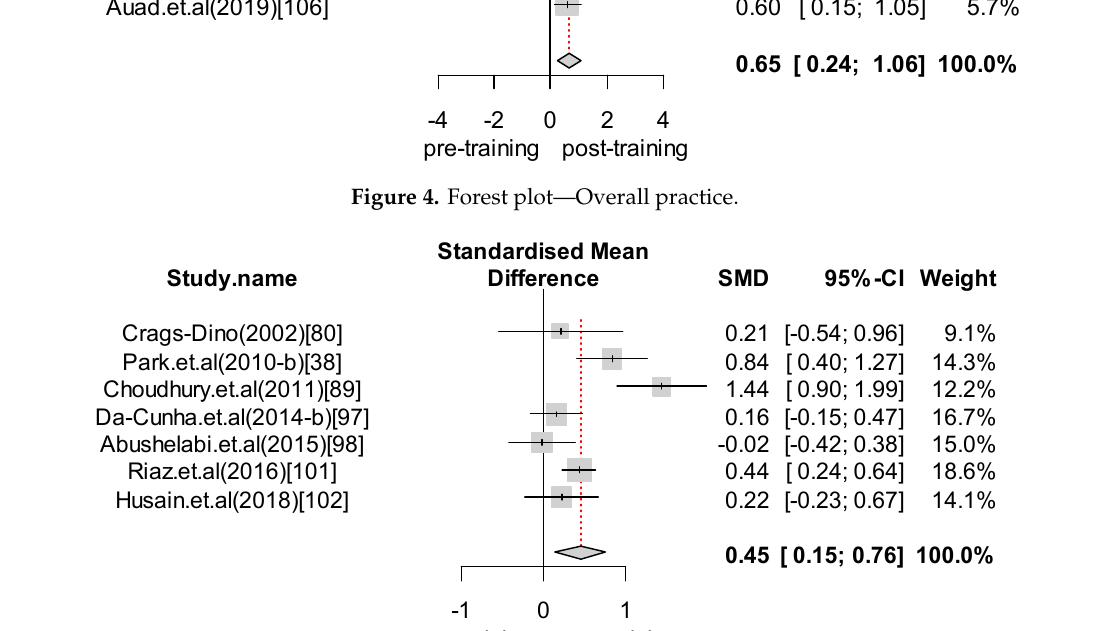
Figure 6. Forest plot—Self-reported practice. 4. Discussion This systematic review has summarized the effects of training interventions on the knowledge, attitudes, and practices of food handlers towards food safety and hygiene. Change in knowledge was assessed in 26 out of 31 studies; therefore, this was the most frequently reported outcome. This result is consistent with previous studies [58,107], and a significant amount of information is available, so it is probably easier to measure knowledge than attitude or practice. We found evidence that training interventions have a significant effect on increased knowledge toward food safety and hygiene across different type of settings such as fresh produce [91], food service operators [108], schools [80], restaurants [82], households [101], and multi-settings [97]. On the other hand, one study found no difference in knowledge between a control and an intervention group except for a positive attitude, so it can be considered to be optimistically biased [90]. This phenomenon has been demonstrated in previous research [90,109,110]. Attitude was assessed in 12 out of 31 studies, most of them assessing one intervention while some studies evaluated two [9,95] or three interventions [87]. Considering the summarized effect size, a SMD = 0.28 suggests a moderate effect for the positive attitude of food handlers; this is similar to previous studies [57,58,66]. Both studies [9,95] reported similar improvements in attitudes, either